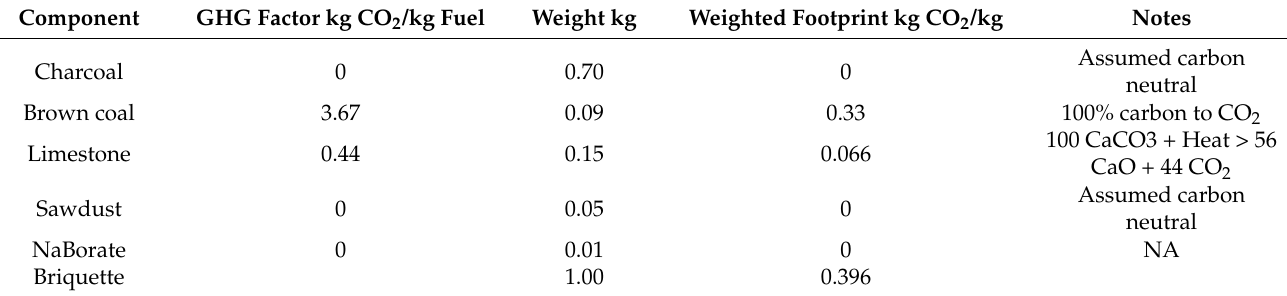
Table 3. Combustion footprint of Kingsford charcoal briquettes.